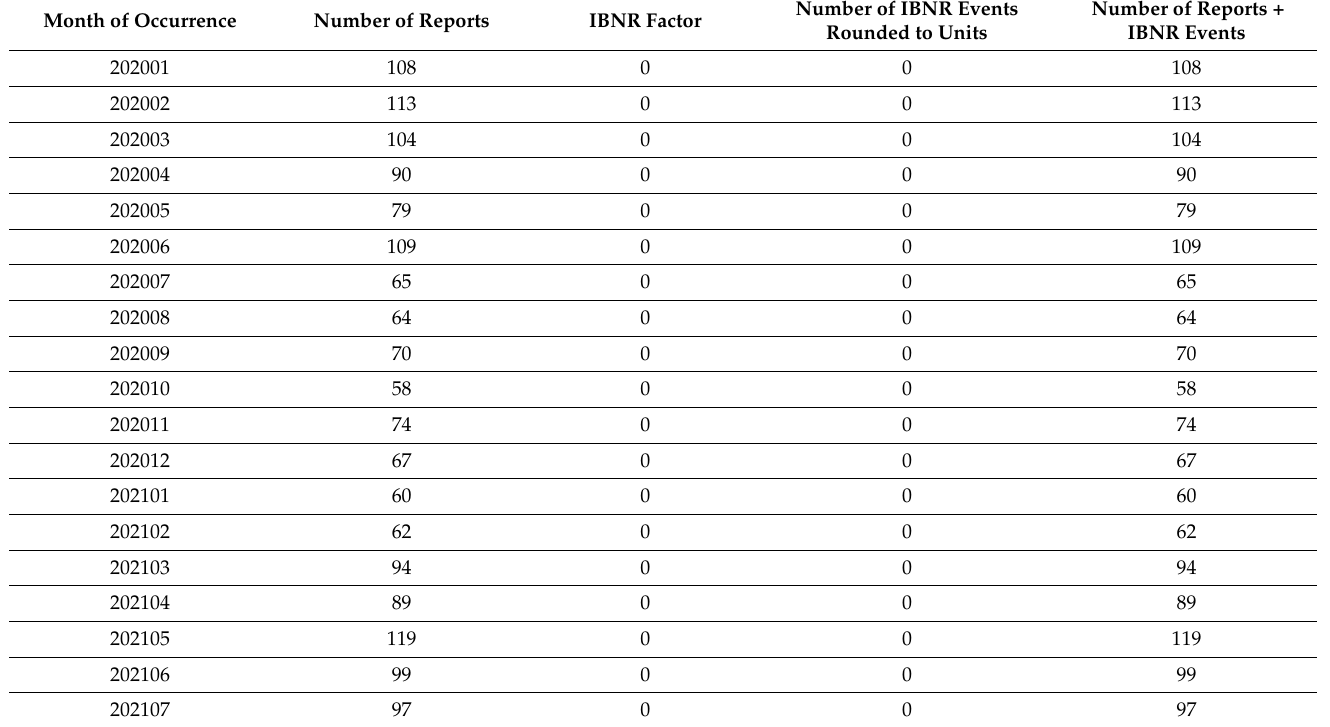
1919 events. Table 2 summarizes the incident-reporting database. Table 2. Incident-reporting database ordered by month of occurrence; total number of reports (used to estimate the number of IBNR events); IBNR factor (obtained with successive multiplications of the progression index); estimated number of IBNR events (the reported number multiplied by the IBNR factor); sum of the number of reports and IBNR events.